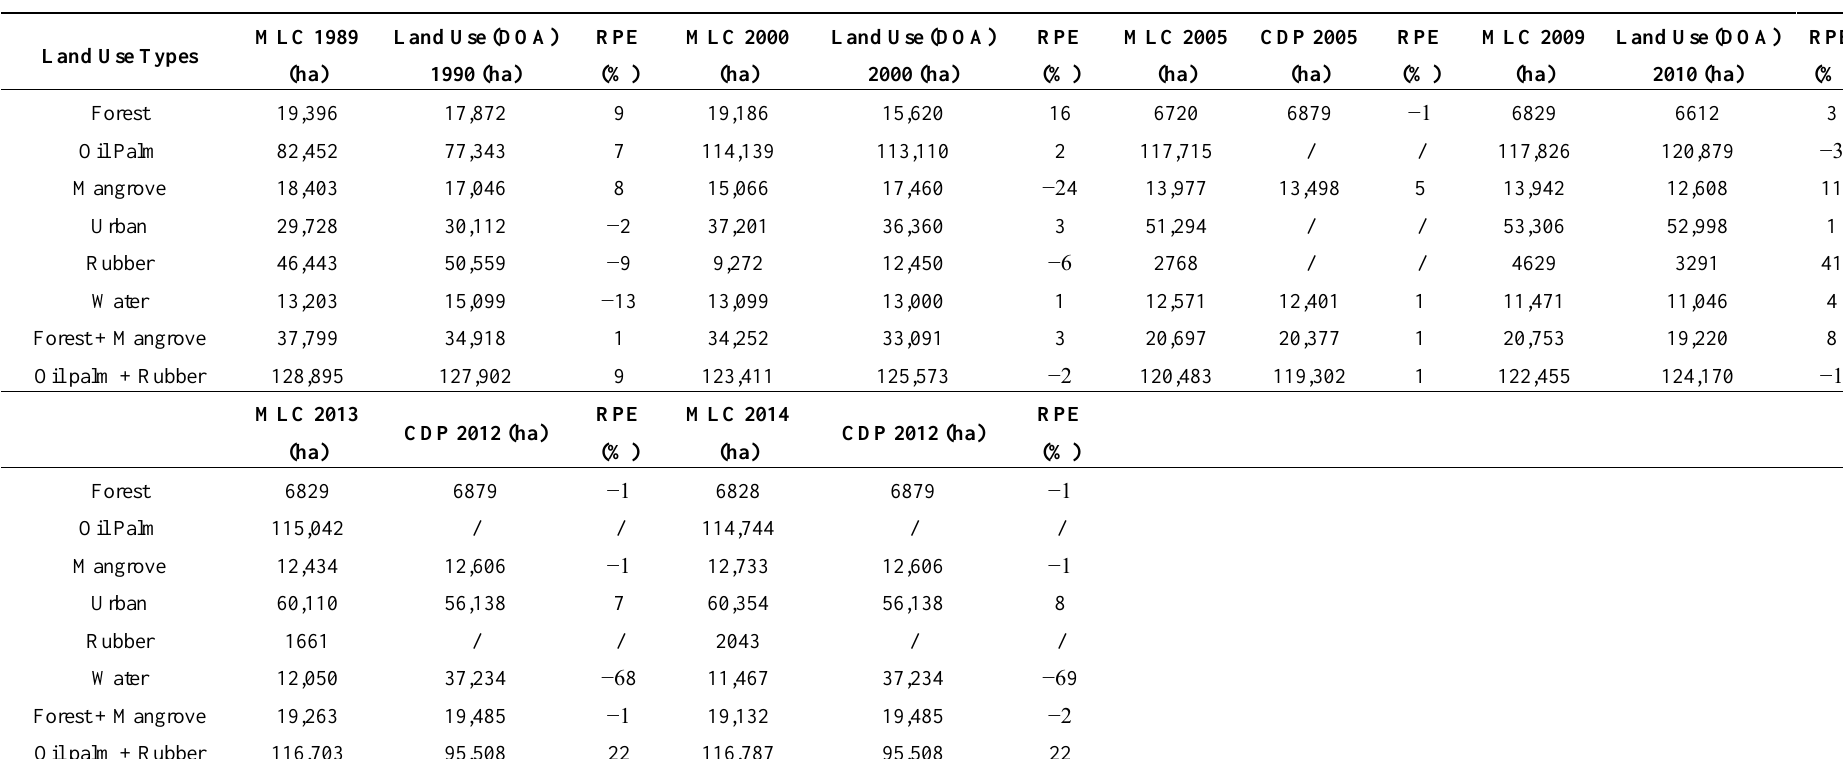
Table 3. Comparison between land use/land cover (LULC) produced by Maximum Likelihood Classification technique, land use map produced by the Department of Agriculture Malaysia (DOA) and the Comprehensive Development Plan (CDP) ii (unpublished). RPE (Relative Predictive Error) quantifies the mean percentage difference between land cover classified by MLC and land cover produced by DOA and IRDA. RPE provides the direction of changes (underestimation (negative sign) or overestimation (positive sign)) in predicted values compared to measured